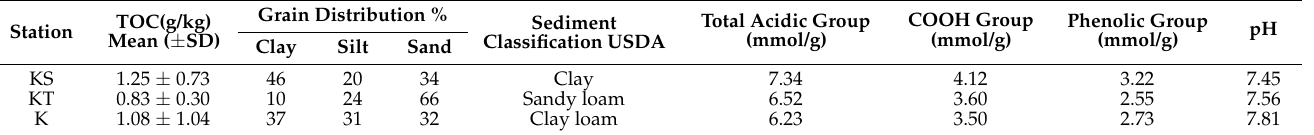
Table 2. Properties of the marine